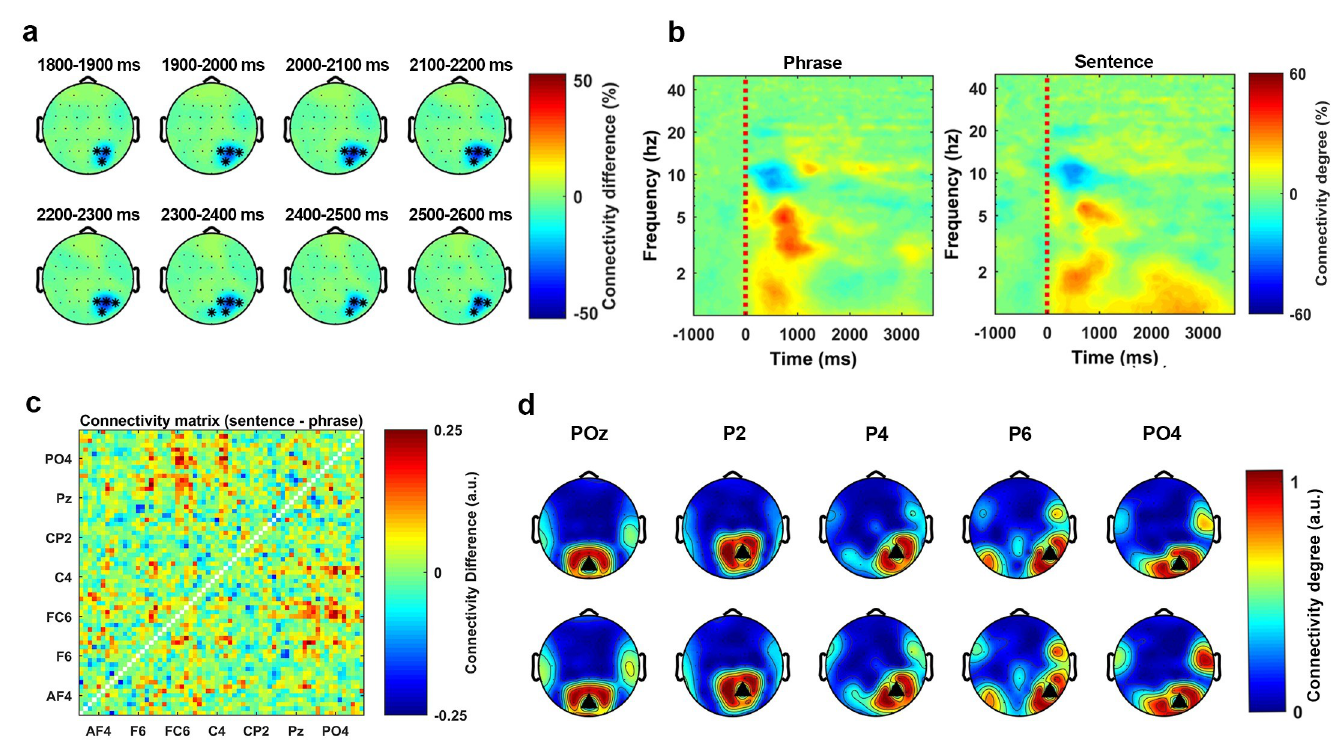
Fig 3. Low-frequency phase connectivity separates phrases and sentences. Statistical analysis on the phase connectivity degree was conducted using a nonparametric cluster-based permutation test (1000 times) on a 3500-ms time window, which started at the audio onset and over the frequencies from 1 Hz to 8 Hz. The results indicated that the phase connectivity degree was higher for the sentences than the phrases ( p < 0.01 �� , 2-tailed). (a) The temporal evolution of the cluster. The activity was drawn by using the averaged connectivity degree of the phrases minus the connectivity degree of the sentences. The topographies were plotted in steps of 100 ms. (b) The time– frequency decomposition of the connectivity degree, which was averaged over all the sensors in the cluster. The left and the right panel show the connectivity degree of the phrase condition and the sentence condition, respectively. (c) The matrix representation of the phase connectivity differences between the phrases and the sentences. The figure was drawn by using the averaged connectivity matrix of the sentences minus the averaged connectivity matrix of the phrases. (d) All the sensors in this cluster were used as the seed sensors to plot the topographical representation of the phase connectivity. The upper panel and the lower panel show the phase connectivity of the phrases and the sentences,